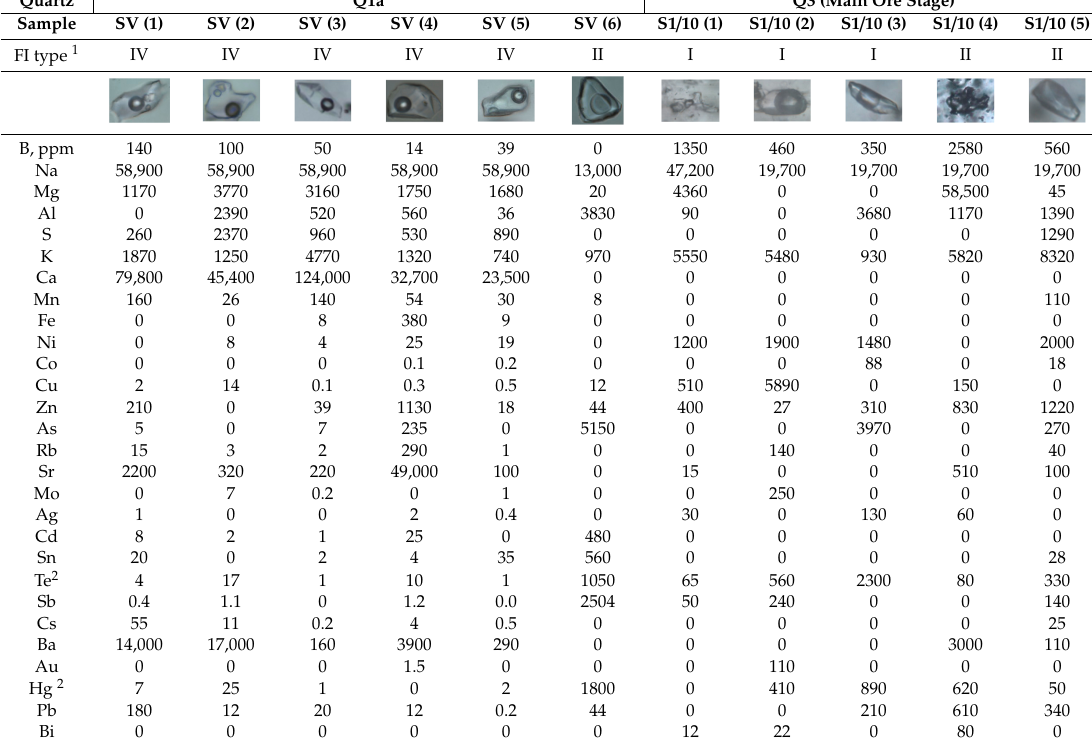
Table 4. Fluid composition according to LA-ICP-MS of individual fluid inclusions in quartz of the Svetlinsk